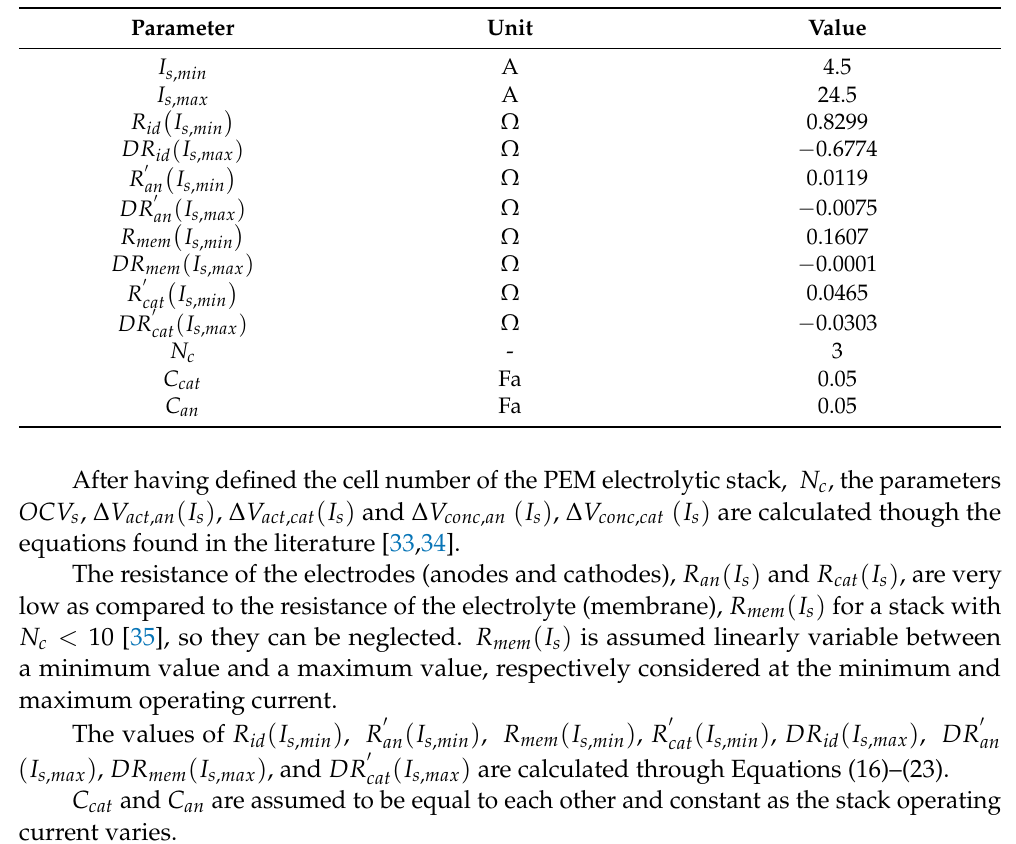
Table 3. Main input parameters of PEM electrolytic stack.